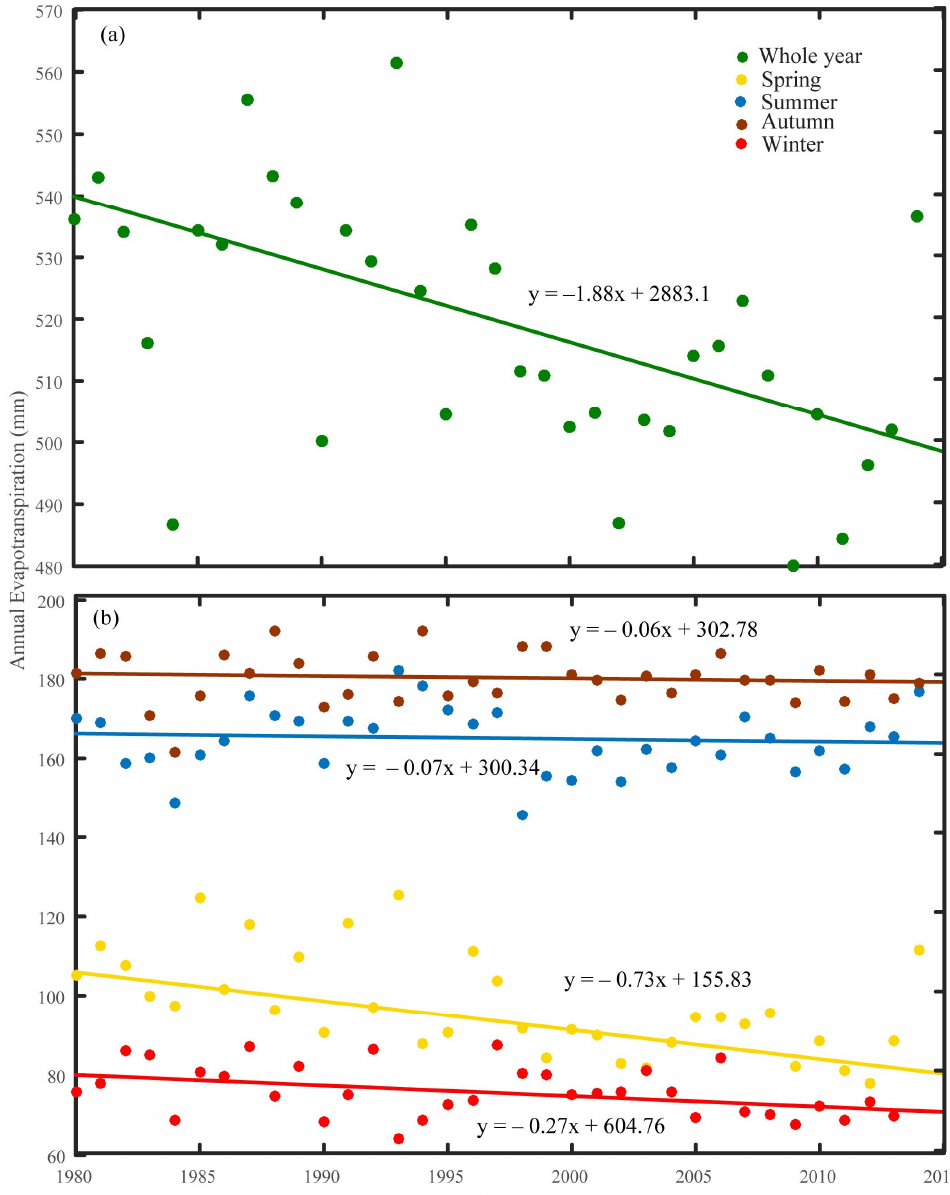
Figure 5. Interannual variations in total ET for ( a ) the whole year and ( b ) four seasons for the period 1980–2014 in the Nile Basin: a positive (negative) sign indicates an upward (downward) trend.